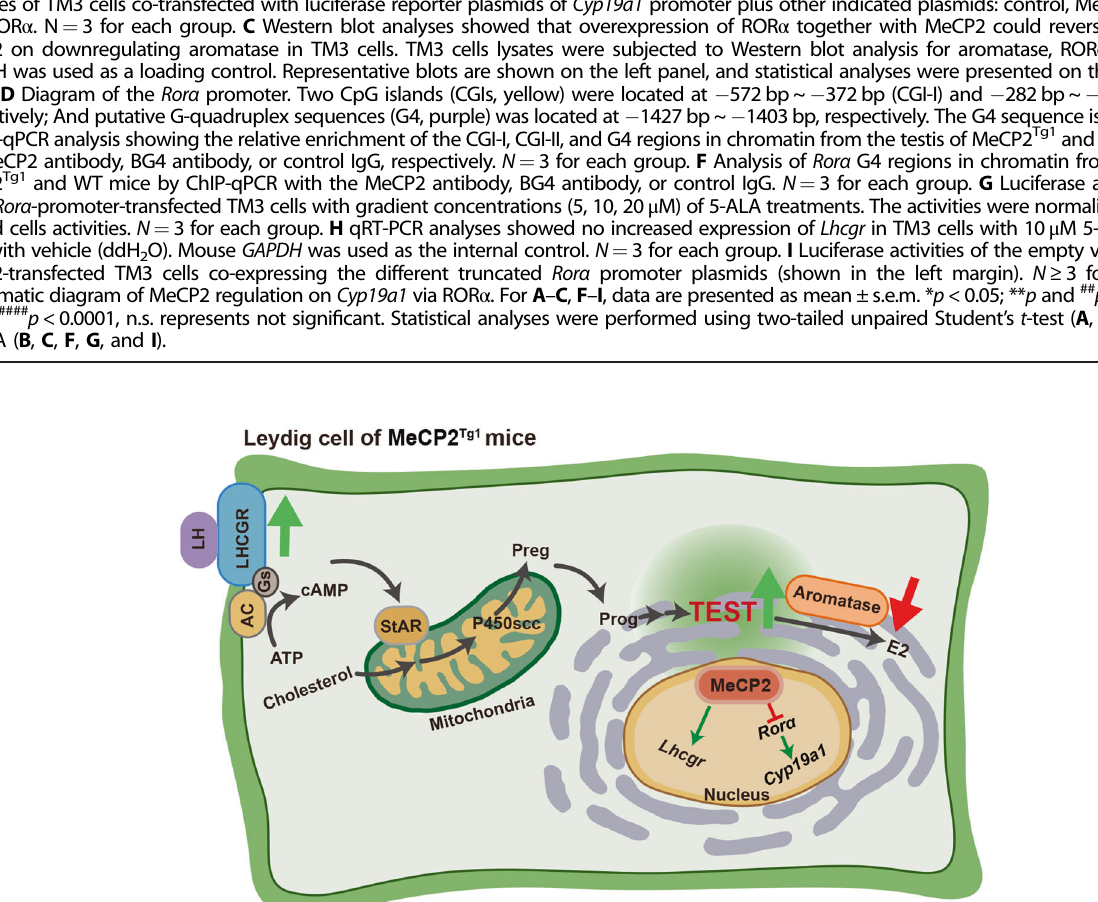
Fig. 6 MeCP2 regulates Cyp19a1 via ROR α . A qRT-PCR analysis showing the relative expression of Ror α in mouse testis from MeCP2 Tg1 mice or WT littermates, Mouse GAPDH was used as an internal control. Results were normalized to GAPDH in the same sample. N = 6 for each group. B Luciferase activities of TM3 cells co-transfected with luciferase reporter plasmids of Cyp19a1 promoter plus other indicated plasmids: control, MeCP2 or MeCP2 plus ROR α . N = 3 for each group. C Western blot analyses showed that overexpression of ROR α together with MeCP2 could reverse the effect of MeCP2 on downregulating aromatase in TM3 cells. TM3 cells lysates were subjected to Western blot analysis for aromatase, ROR α , and MeCP2. GAPDH was used as a loading control. Representative blots are shown on the left panel, and statistical analyses were presented on the on the right panel. D Diagram of the Ror α promoter. Two CpG islands (CGIs, yellow) were located at − 572bp~ − 372bp (CGI-I) and − 282bp~ − 117bp (CGI-II), respectively; And putative G-quadruplex sequences (G4, purple) was located at − 1427bp~ − 1403bp, respectively. The G4 sequence is shown below.